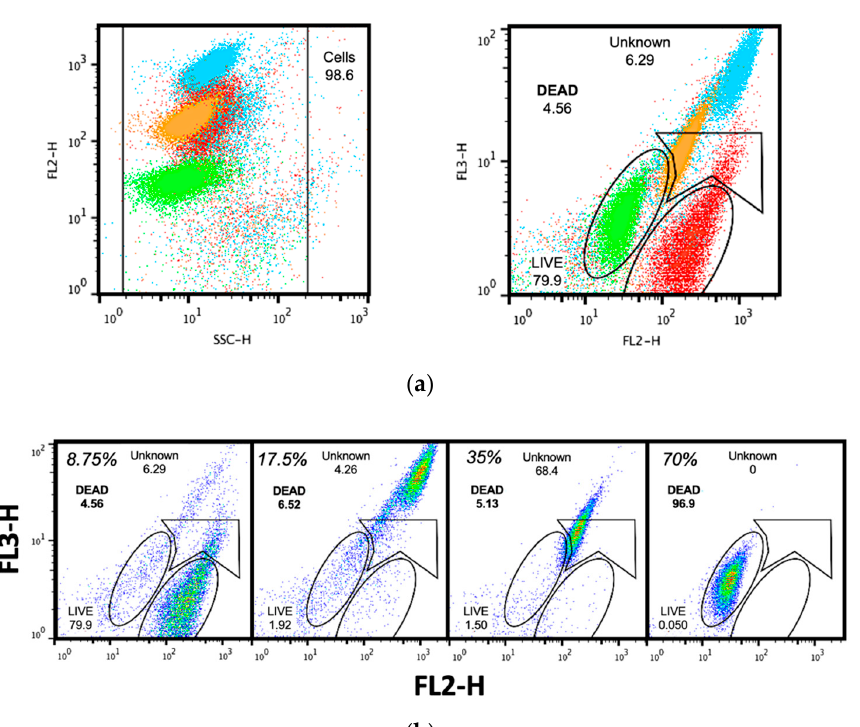
Figure 1. Dot plots of FC sensibility for dead cells detection. ( a ) Merged dot plots of red fluorescence (FL2-H) vs side scatter (SSC-H) (left panel) and of green fluorescence (FL3-H) vs red fluorescence (FL2-H) (right panel) for isopropanol dilutions at 8.75% (red), 17.5% (blue), 35% (orange) and 70% (green); ( b ) Dot plot of regions acquired from green fluorescence (FL3-H) vs red fluorescence (FL2-H) for individual dilutions. Numbers represent the cell percentage with respect to the total acquired events.